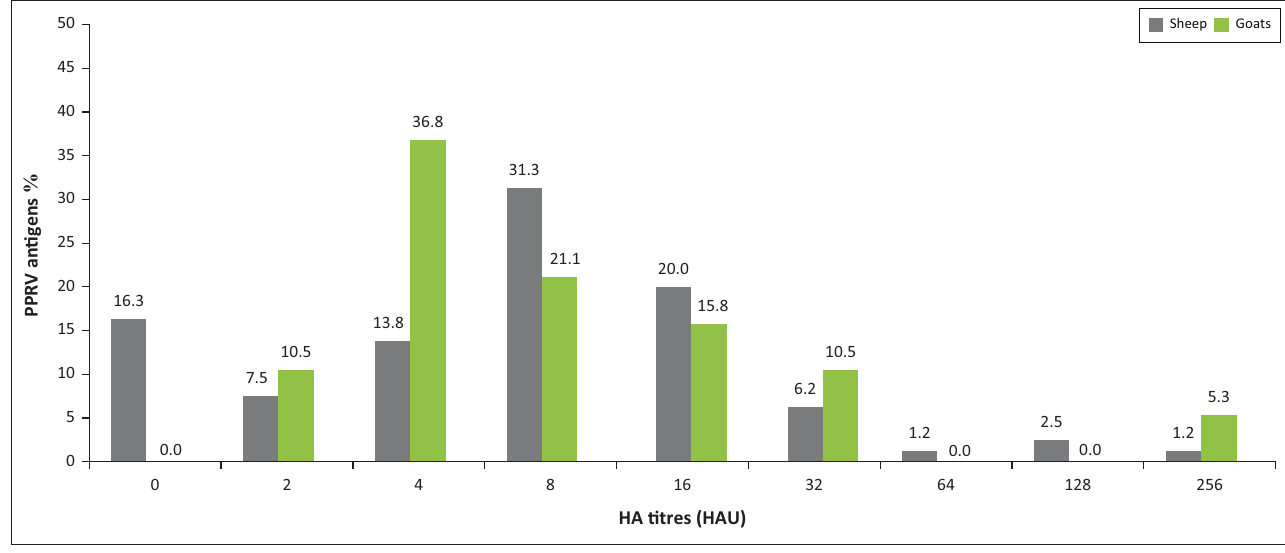
FIGURE 4: Detection of PPRV in pneumonic lungs of sheep or goat collected from Al-Hasaheisa slaughterhouse, Sudan. Distribution of haemagglutination